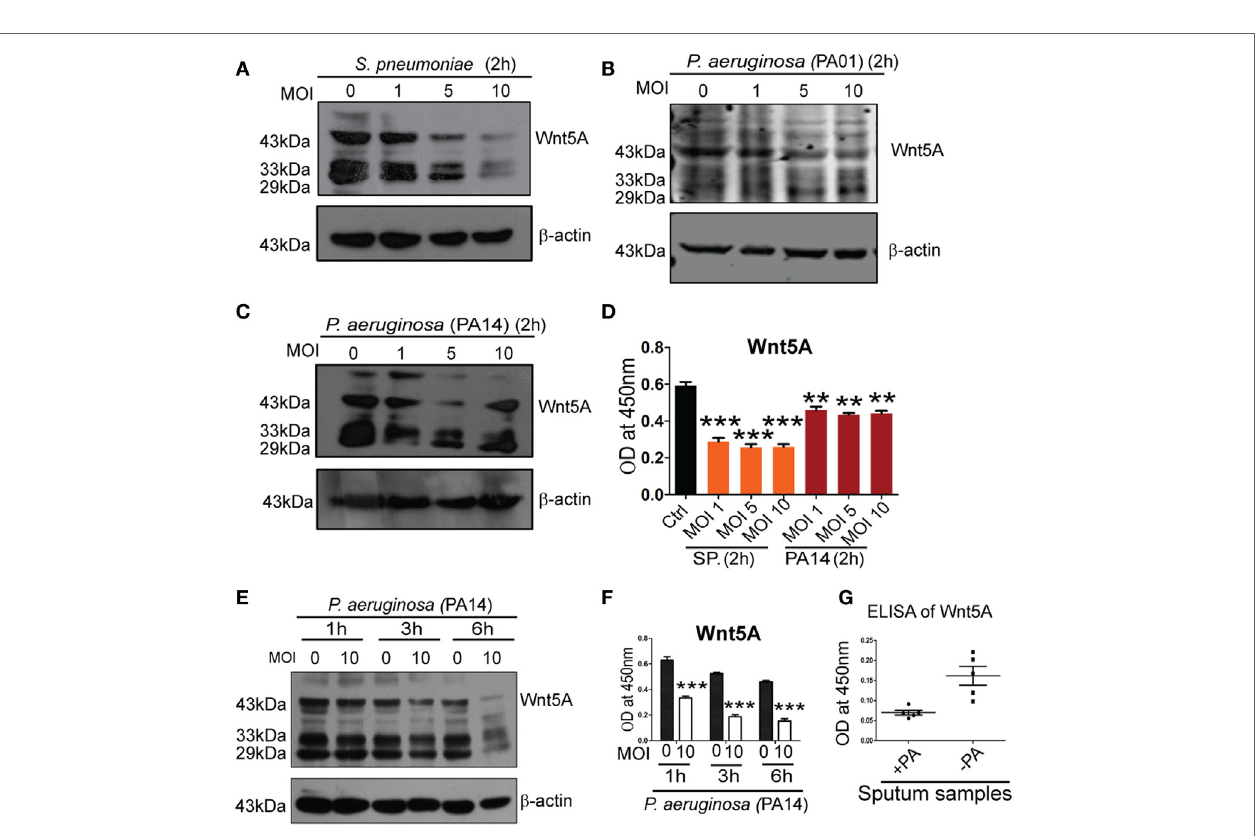
FigUre 2 | Pseudomonas aeruginosa (PA) and Streptococcus pneumoniae (SP) infection lead to reduction of both cell associated and secreted Wnt5A. There is decrease in both cell associated (a–c) and secreted (D) Wnt5A upon infection with PA (strain: PA14 and PA01) and SP (strain: A66) using different multiplicity of infection (MOI) ( n = 3). MOI 10 infection of PA for different lengths of time produces similar results (e,F) ( n = 3). (g) Wnt5A level in sputum samples of COPD patients with and without PA infection ( n = 5). Data represented as mean ± SEM; * p ≤ 0.05, ** p ≤ 0.005, *** p ≤ 0.0005.